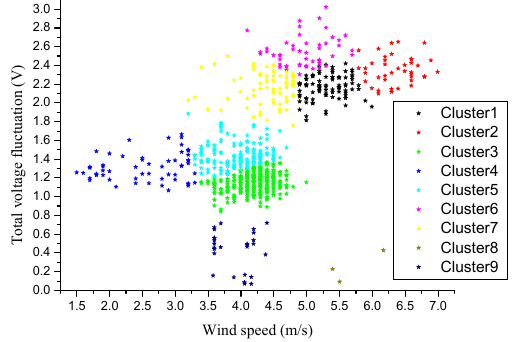
Figure 8. The clustering result (k = 9).